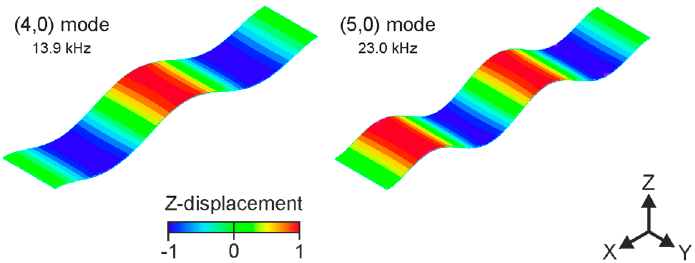
Figure 2. Modal shapes and resonant frequencies for the modes involved in the motor design: (4,0) and (5,0) modes. The colored scale represents the normalized modal displacement in the Z -axis.